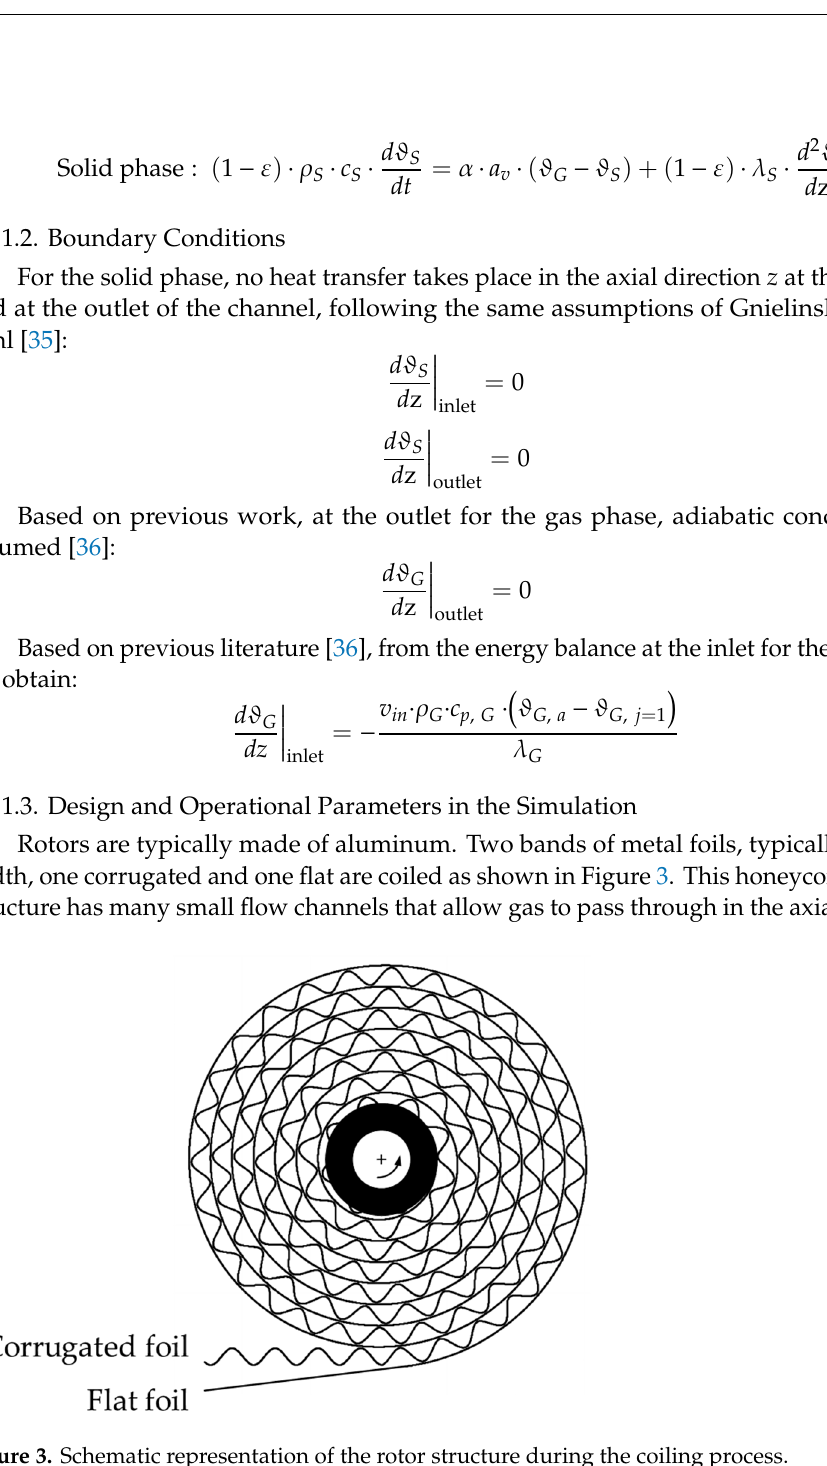
Figure 3. Schematic representation of the rotor structure during the coiling